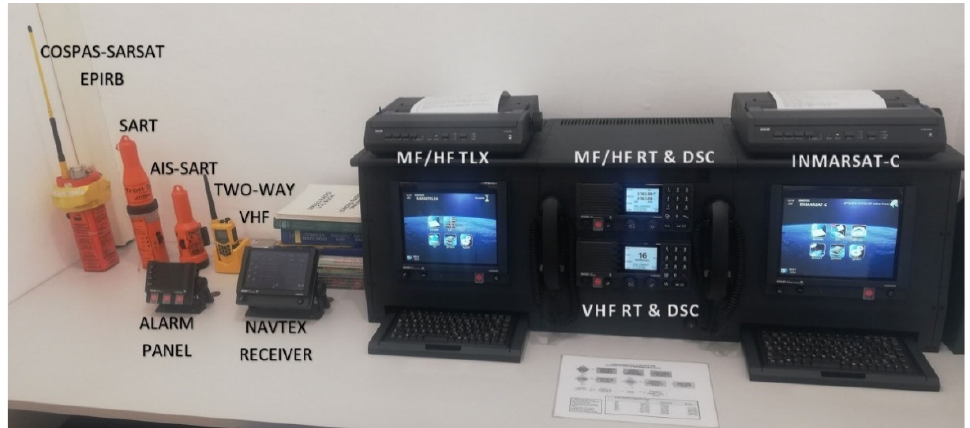
Figure 1. Typical Global Maritime Distress and Safety System (GMDSS) radio station and equipment for sea area A3.